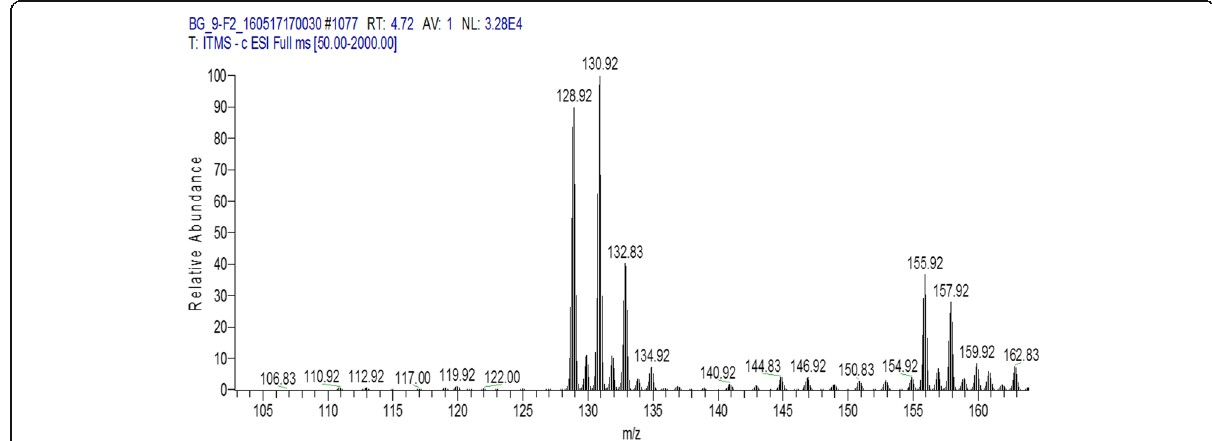
Fig. 3 LC MS/MS Chromatogram of fraction 2 (F2) from hexane extract of P. granatum peel showing Coumaric acid